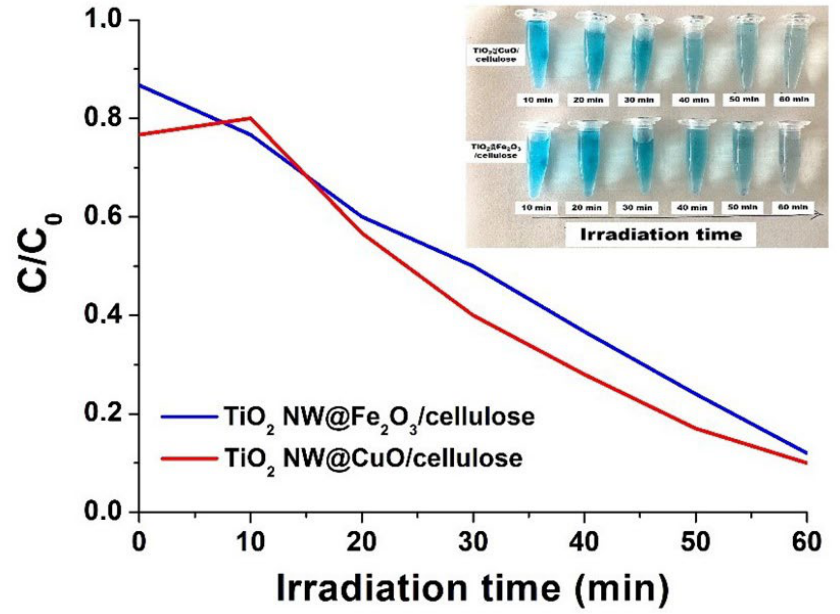
Figure 5. Photocatalytic performance of TiO 2 NW@Fe 2 O 3 /cellulose (blue curve) and TiO 2 NW@CuO/cellulose (red curve) hybrid membranes in MB degradation.